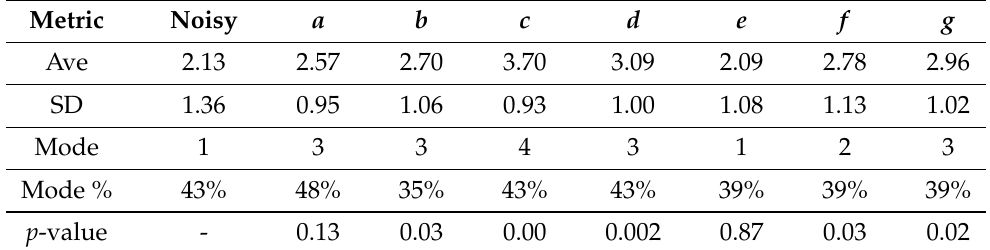
Table 4. Subjective evaluation results.